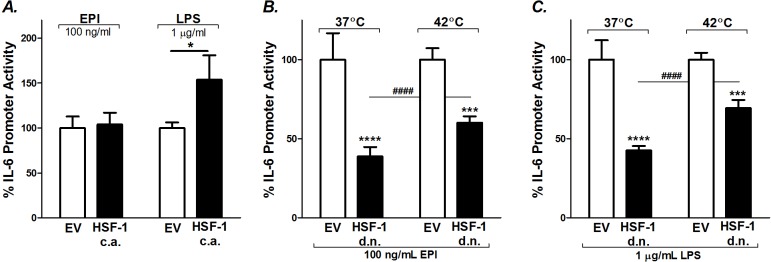
Effects of HSF-1 on EPI- and LPS-induced IL-6 promoter activity.A) C2C12 myoblasts were transfected with mIL-6.Luc, pRL-TK and constitutively active (c.a.) HSF-1 or its empty vector (EV) and differentiated into myotubes. Myotubes were treated with EPI (100 ng/ml) or LPS (1 μg/ml) at 37°C 6 h. B and C) The effects of HSF-1 inhibition on EPI- and LPS-induced IL-6 promoter activity during basal (37°C 6 h) and heated (42°C 1 h and 37°C 5 h) conditions. In these experiments C2C12 myoblasts were transfected with mIL-6.Luc, pRL-TK together with a dominant negative (d.n.) HSF-1 mutant or its EV and differentiated into myotubes. Results represent multiple cultures, 5 independent experiments, two samples per experiment; multiway ANOVA testing. The effects of each treatment group at individual time points are from post-ANOVA least squares contrasts between means. * Comparisons vs. EV; # comparisons among d.n. HSF-1 myotubes at 37 vs. 42°C; * (P<0.05),*** (P<0.001), and **** or #### (P<0.0001).